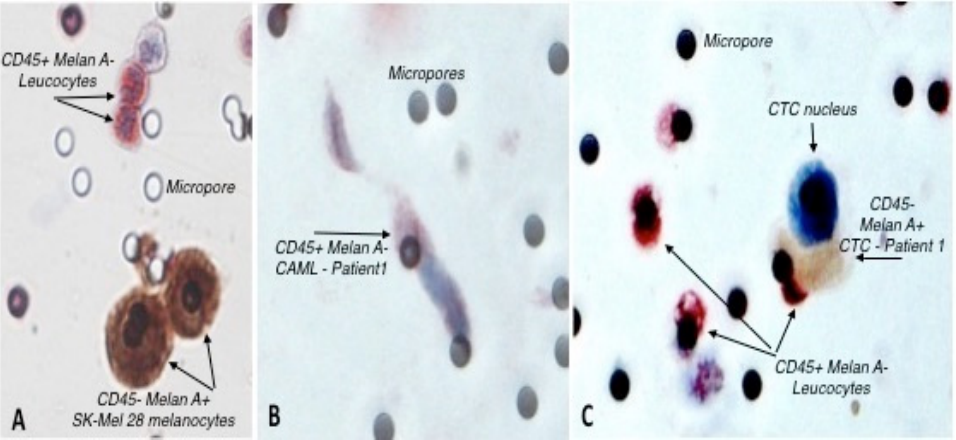
Figure 2. Double ICC. ( A ) Control sample showing CD45+/Melan A − red-stained leucocytes and CD45 − /Melan A+ brown-stained SK-Mel 28 cultured melanocytes; ( B ) Microporous filter from patient 1 showing a CD45+/Melan A − CAML with red-stained cytoplasm and blue-stained nucleus; ( C ) Microporous filter from patient 1 showing a CD45 − /Melan A+ brown-stained CTC located close to CD45+/Melan A − red-stained leucocytes. G × obj. 40.